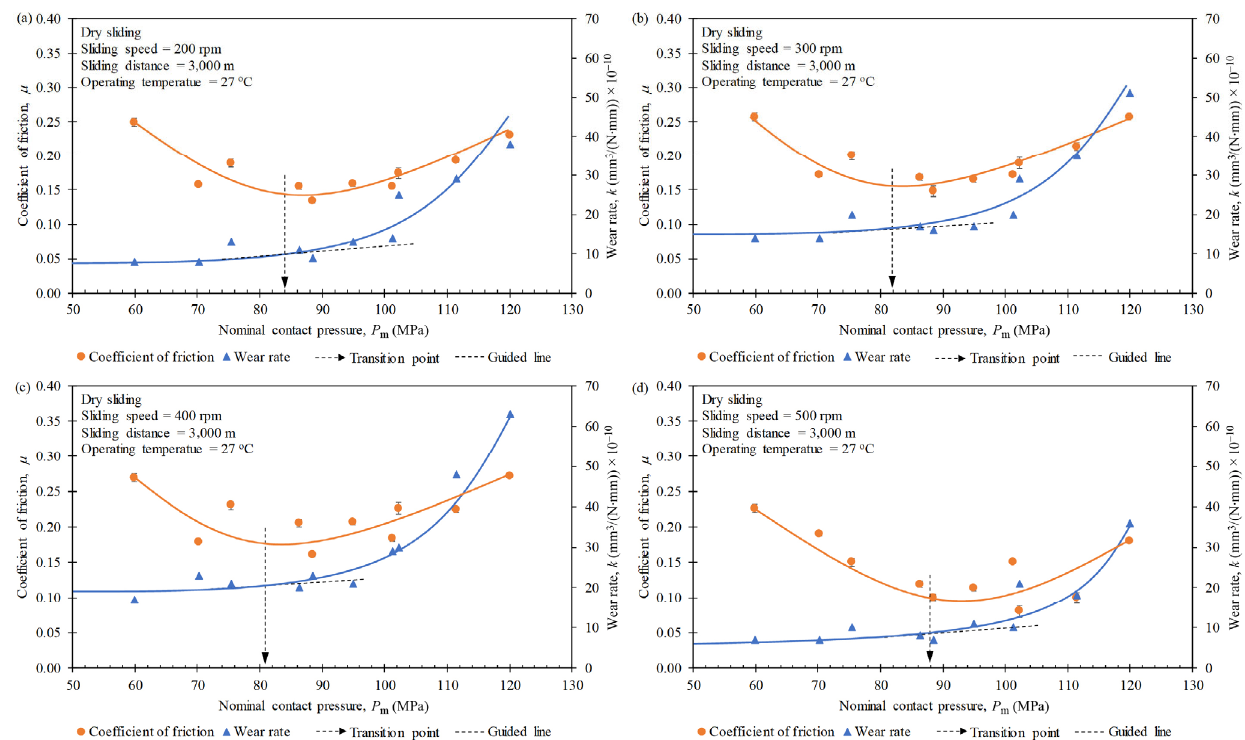
Fig. 5 Transition points from mild to severe wear of an activated carbon-epoxy composite derived from palm kernel at different sliding speeds of (a) 200 rpm, (b) 300 rpm, (c) 400 rpm, and (d) 500 rpm. The error bar is for the standard